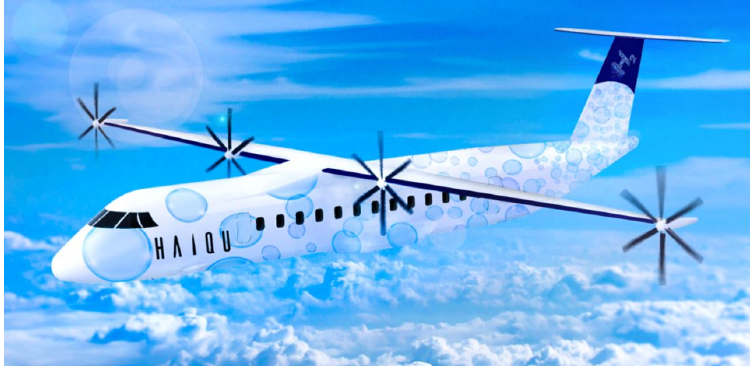
Figure 9. 3D rendering of the HAIQU aircraft.